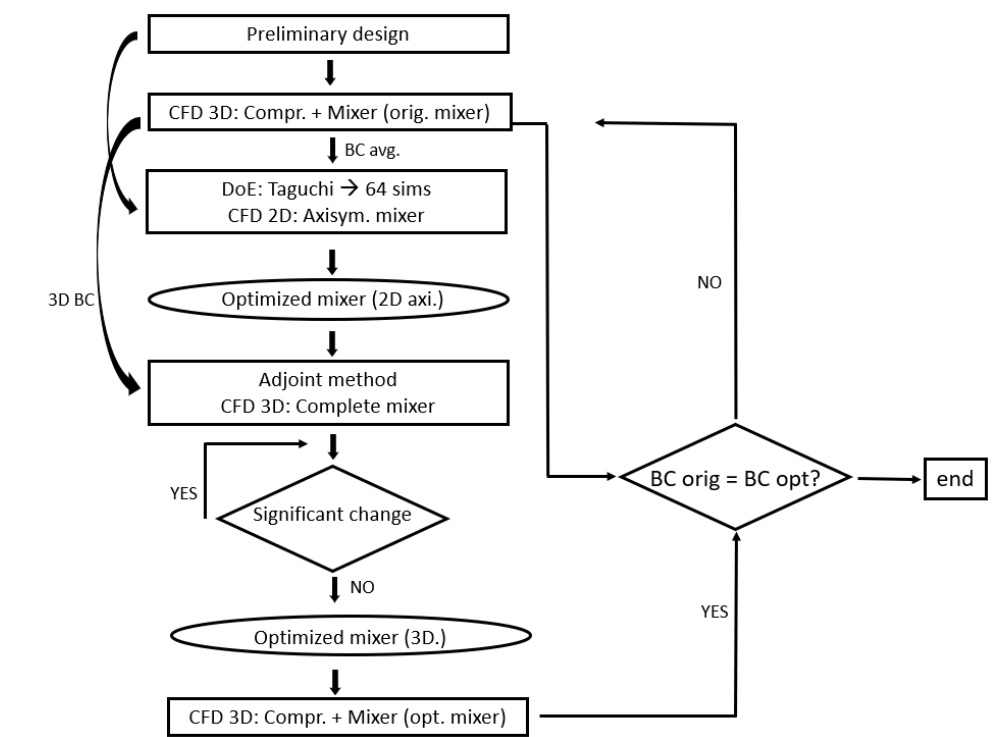
Figure 3. Flux diagram of the uncoupled process In square, the methodology steps. In oval, the results of the optimization